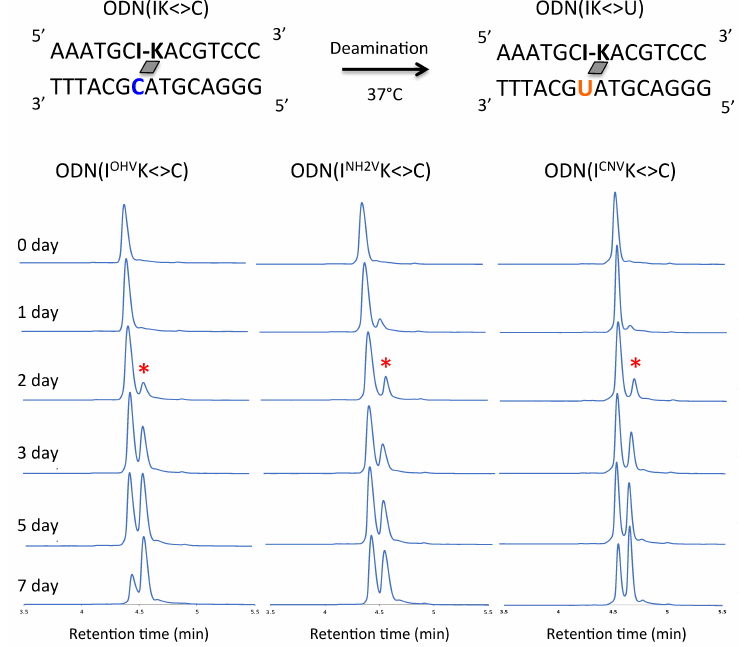
Figure 3. UPLC analysis of the deamination reaction of the photo-cross-linked duplex consisting of ODN(IK) and cODN(C). [ODN(IK<>C)] = 5 µ M in 50 mM Na-cacodylate buffer (pH 7.4) containing 100 mM NaCl. incubated at 37 ◦ C, photo splitting was performed with transilluminator (312 nm) at 37 ◦ C. Peak marked with asterisk ( * ) indicate the newly formed